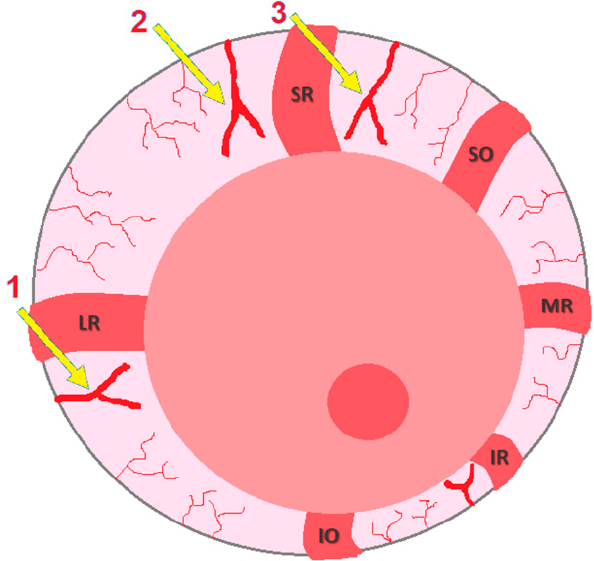
Figure 8. Representation of a rat ocular globe: yellow arrows indicate the cauterized episcleral veins; (1) lateral vein, (2) dorso-lateral vein, (3) dorso-medial vein. Extraocular muscles: SR, superior rectus; SO, superior oblique; MR, medial rectus; IR, inferior rectus; IO, inferior oblique; LR, lateral rectus.